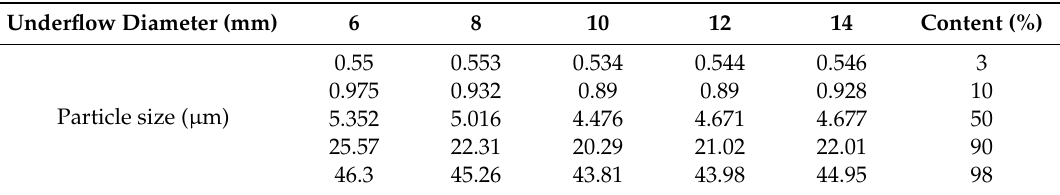
Table 6. Particle size of II